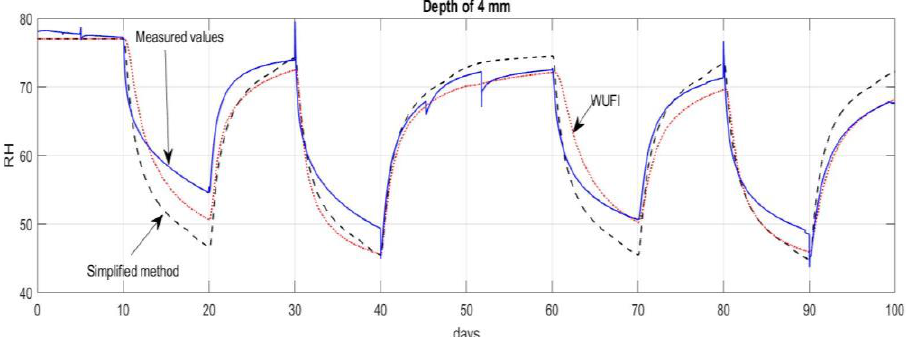
Figure 2. The results at 4 mm depth of the calculated RH in comparison with the measured data. The blue solid line indicates the measured data, the black dotted line is the simulation by WUFI ® Pro and the red dashed line the Simplified model.